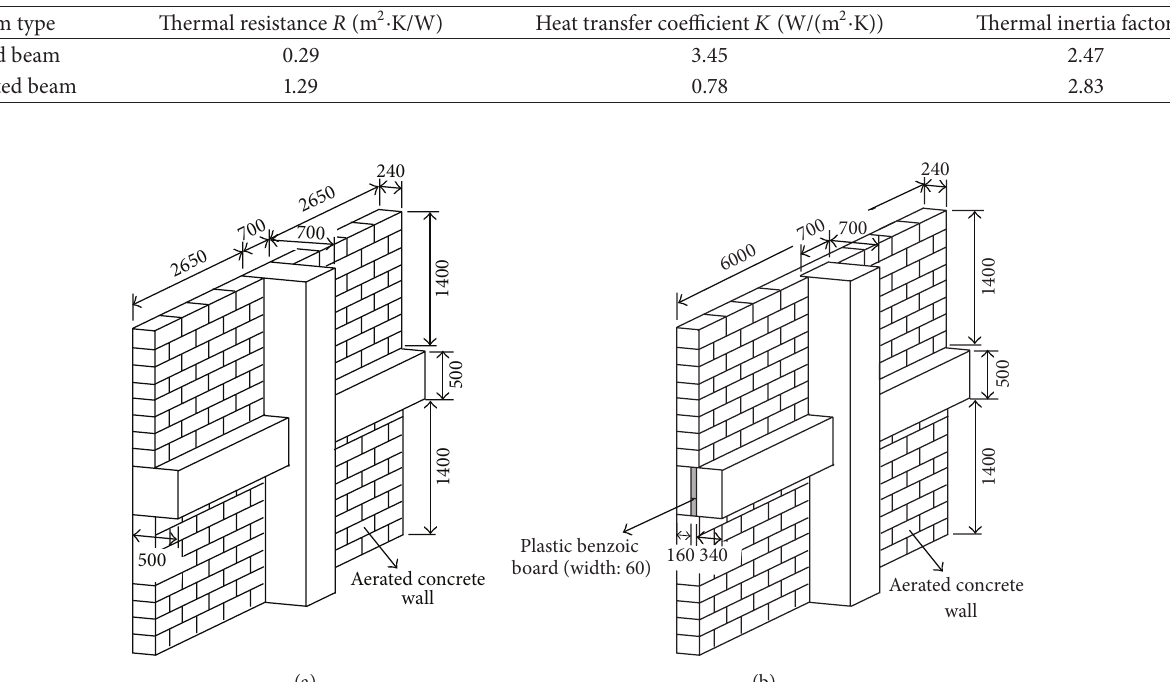
Table 8: Thermal calculation results of the beams.